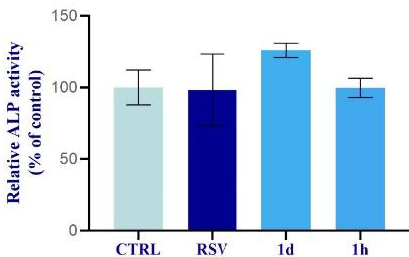
Figure 11. ALP activity of primary human osteoblasts cultured after incubation of 1d and 1h (5 µM) at 14 days. Compound 1d showed higher ALP activity than CTRL, RSV, and 1h . Data are expressed with relation to control cell percentage as mean ± SD.